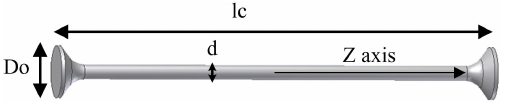
Figure 7. Diabolo core induction